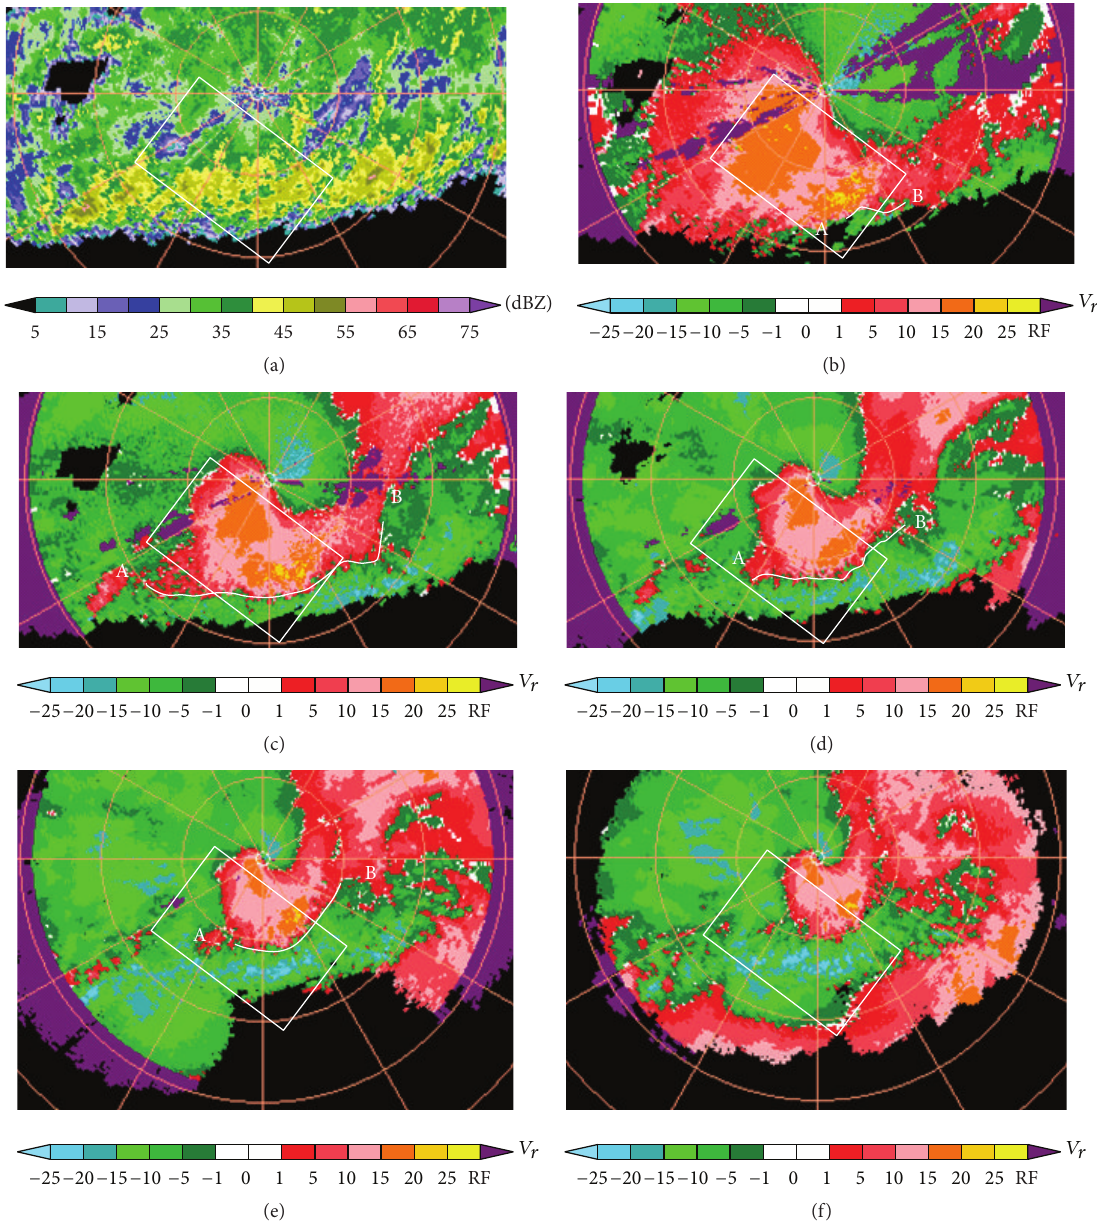
Figure 10: Reflectivity at elevation of 1.5 ∘ (a), storm-relative radial velocity observed by Guangzhou Doppler weather radar at elevation of 0.5 ∘